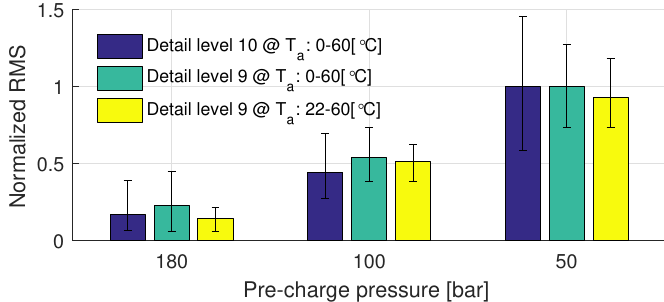
Figure 10. Comparison between detail levels and reduced temperature range. The values are normalized with respect to the value at 50 bar and temperature range 0–60 ◦ C. The error bars indicate the full range of RMS